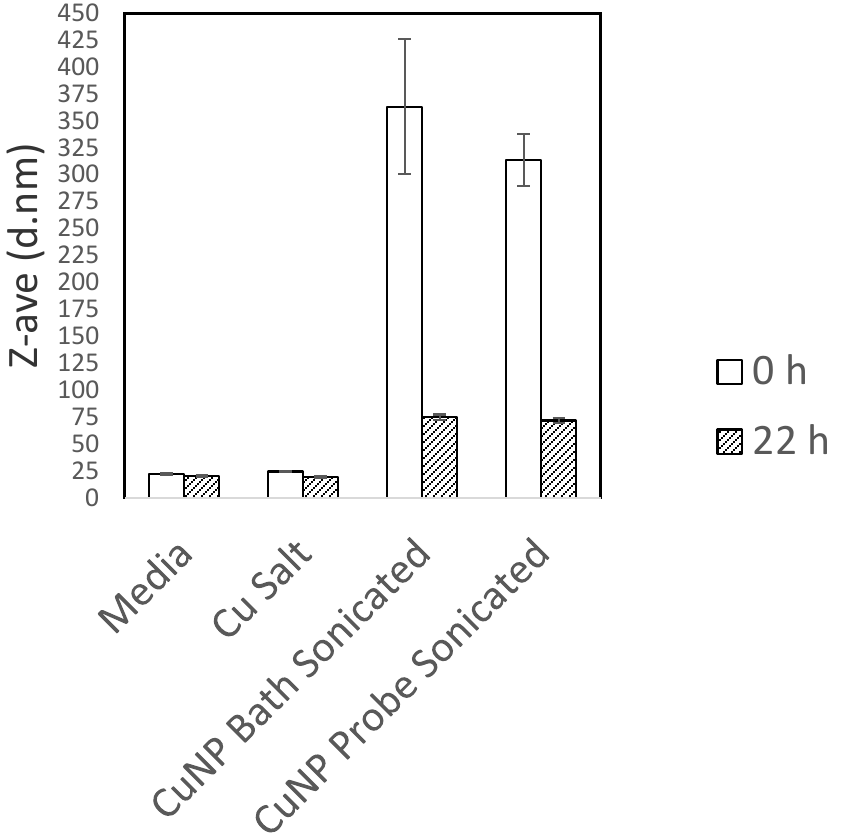
Figure 2. Comparison of the Z-average between complete media, a CuCl 2 solution in media 20 µg Cu/mL, a bath-sonicated 20 µg/mL 40–60 nm CuNP suspension, and a probe-sonicated 20 µg/mL 40–60 nm CuNP suspension immediately after and 24 h after sonication. Ten minutes of sonication was used each time.